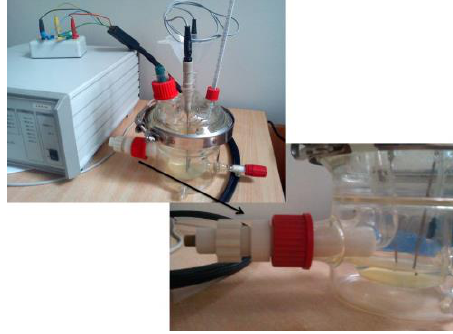
Figure 4. The electrochemical test stand used in the experimental campaign.